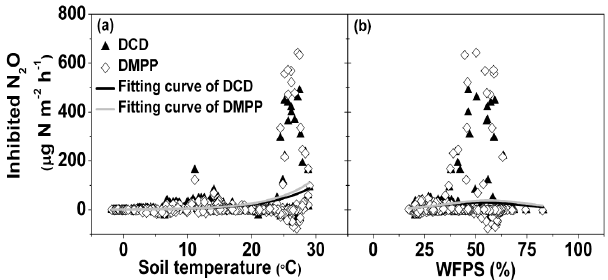
Fig. 5. Relationship between daily averaged soil temperatures, soil water-filled pore space (WFPS) and inhibited N 2 O flux. DCD and DMPP: urea + DCD and urea + DMPP